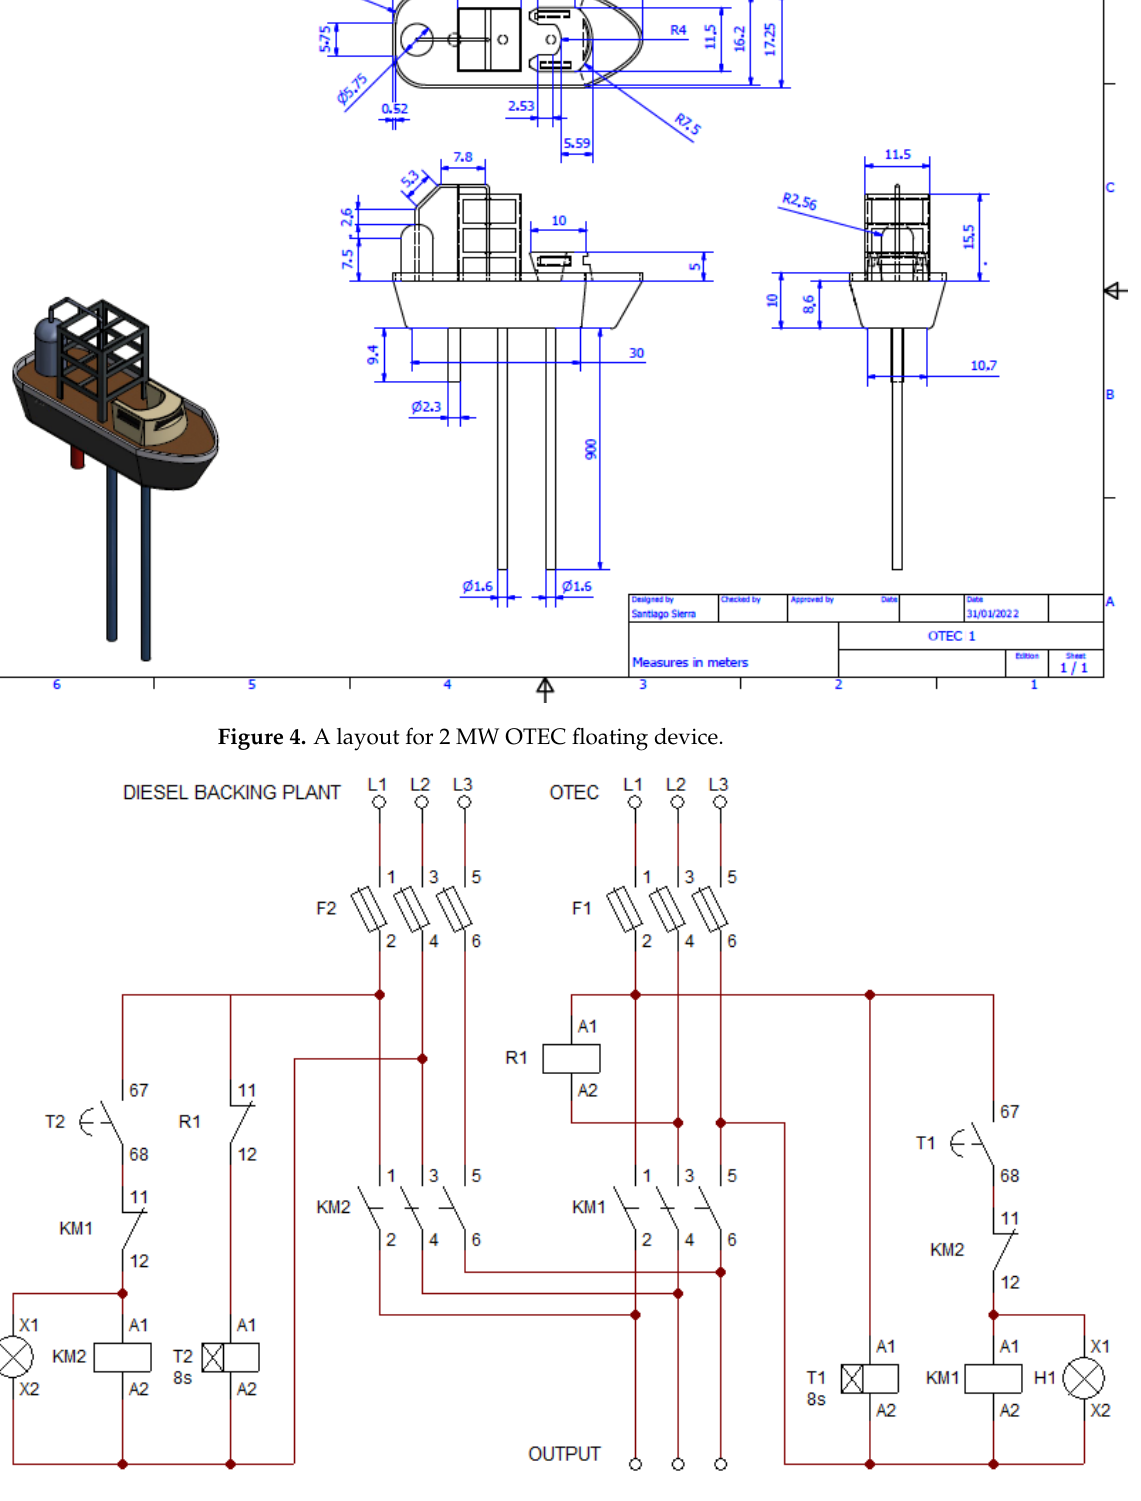
Figure 5. Electrical transfer circuit. In case of a failure, the electric transfer circuit is in charge of switching between energy coming from the OTEC to a backup diesel